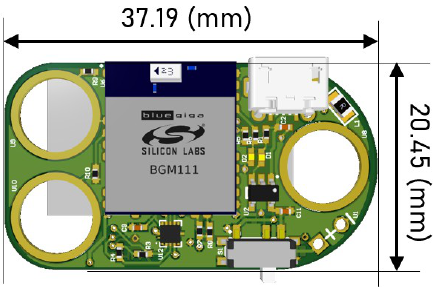
Figure 5. Hardware inertial unit design in a CAD software (dimensions explicit).